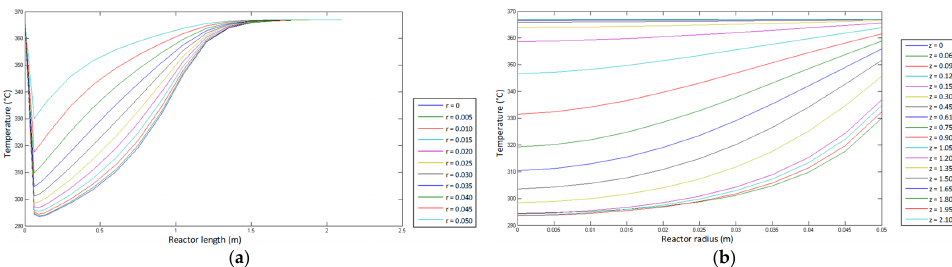
Figure 1. Graphical representation of the conversion profile of cyclohexanol to cyclohexanone: ( a ) conversion profile of cyclohexanol as a function of length for each placement point along the radius of the reactor, and ( b ) conversion profile of cyclohexane as a function of radius for each position longitudinal. Obtained from the data in Table A1.